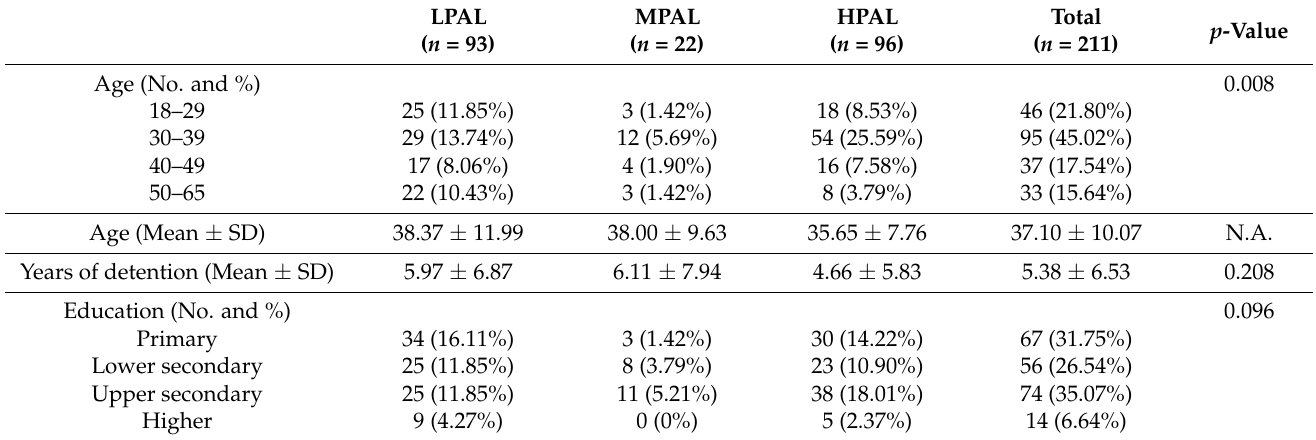
Table 1. Lifestyle and personal data of prisoners by physical activity